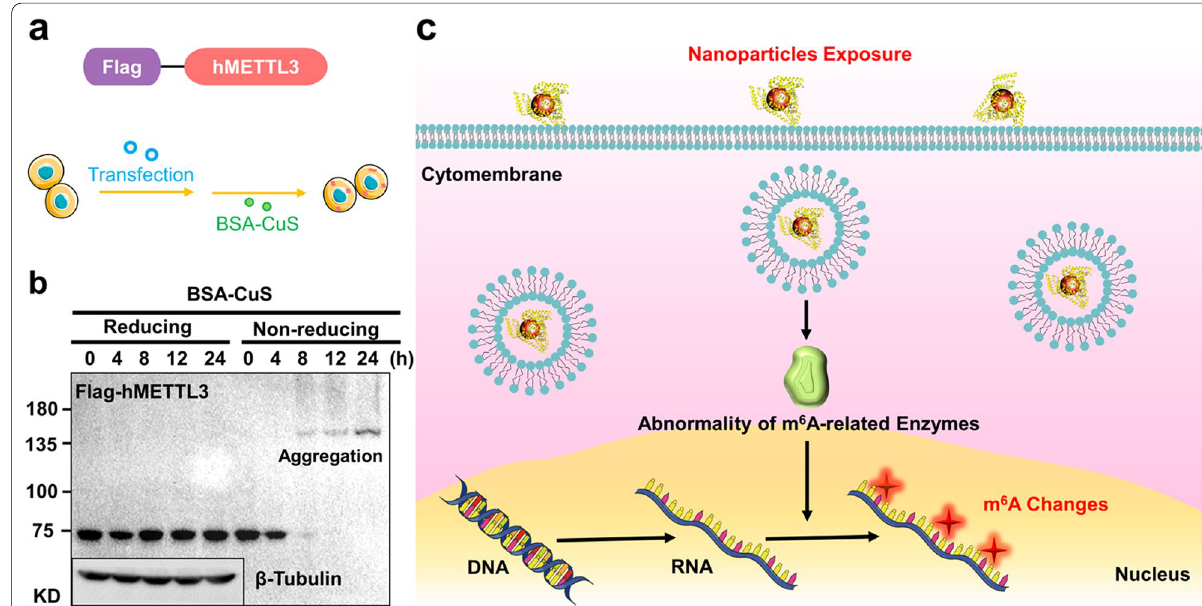
Fig. 6 Possible mechanism for m 6 A changes induced by the BSA-templated NPs. a Schematic illustration of transfection of Flag-tagged human METTL3 (Flag-hMETTL3) into HEK293T cells, followed by exposure to 200 μg/mL BSA-CuS NPs for 24 h. b Redox-western blot analysis of Flag-hMETTL3 in reduced and non-reduced conditions. A total of 50 μg protein was loaded (β-tubulin was used as a control for loading). c Schematic representation of the potential mechanism for m 6 A changes induced by the BSA-templated